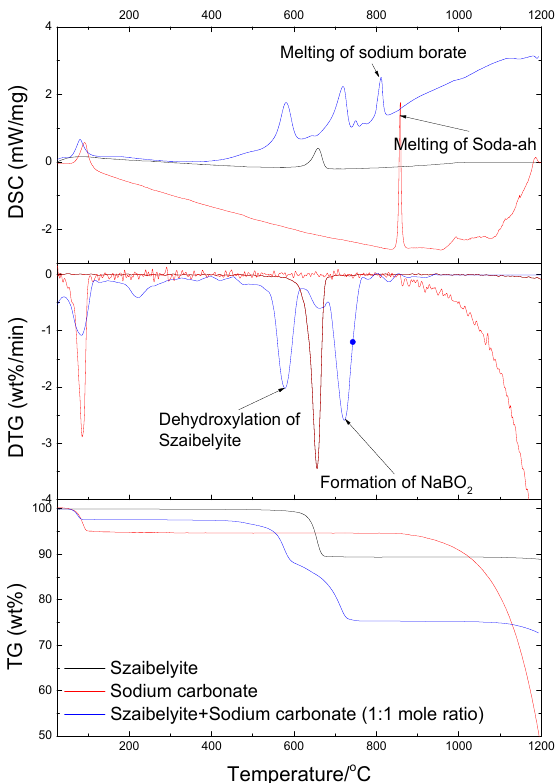
Figure 7. TG-DSC curves of szaibelyite, sodium carbonate and the mixture of szaibelyite and sodium carbonate (argon atmosphere, 10 °C/min).